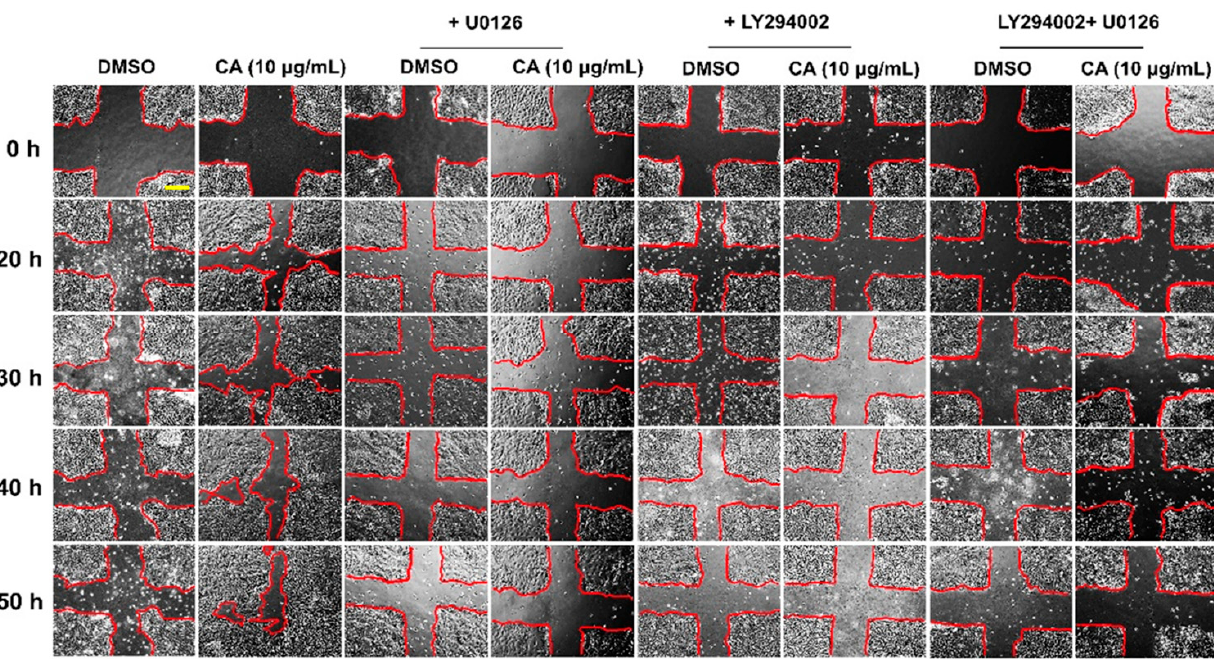
Figure 10. U0126 and LY294002S strongly inhibited the healing-promoting activities of CA extract. Phase-contrast microscopy at 10× magnification (scale bar = 200 µm) was performed to monitor the rate of migration into the wounded site of HaCaT cells treated with CA extract in media containing U0126, LY294002, or the combination of U0126 and LY294002 over the course of 50 h. Regions confined by the red lines indicate the space with no cell occupation. Data are from 3 different experiments.